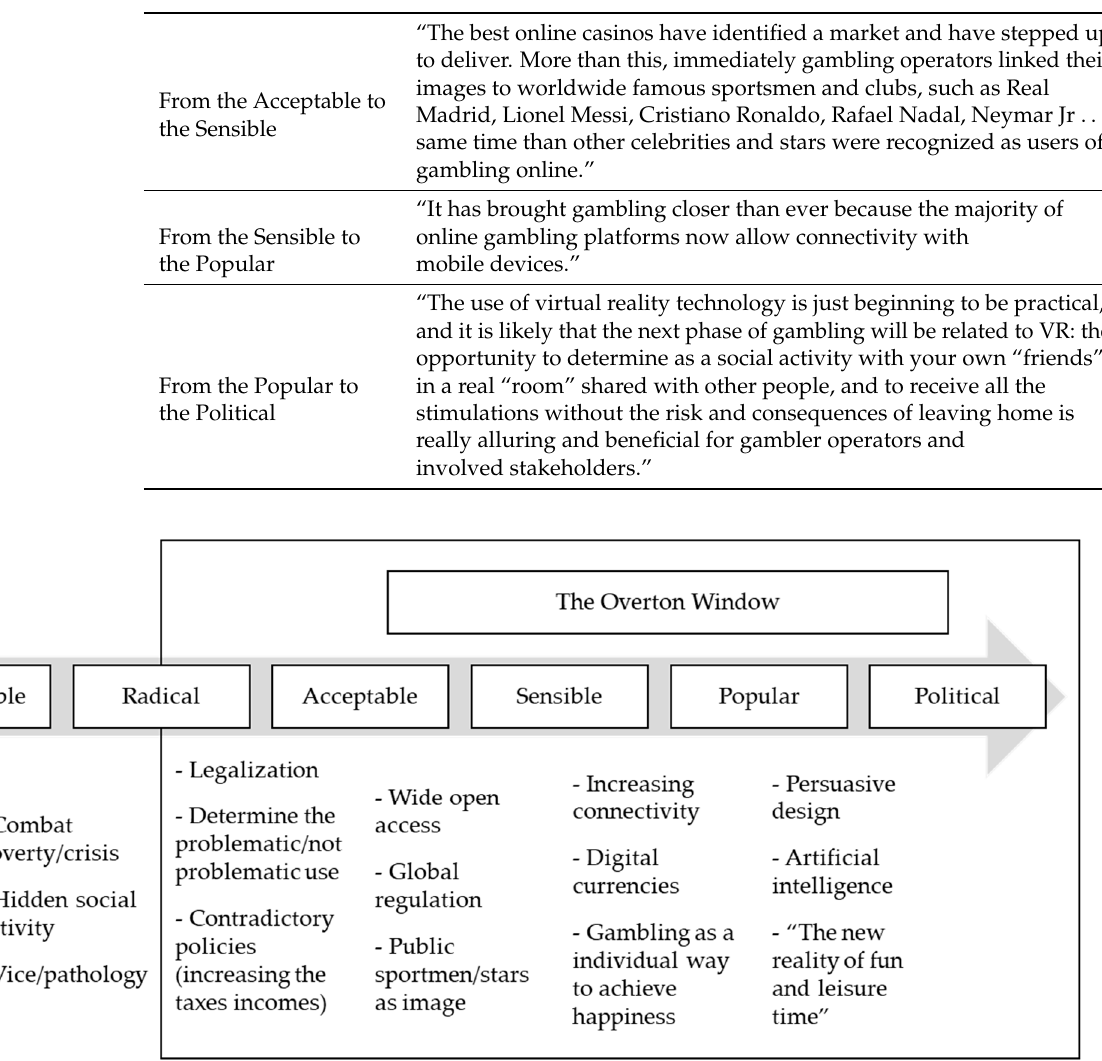
Figure 2. The Overton window in gambling regulation. Table 1. Overton window phases and verbatim examples.